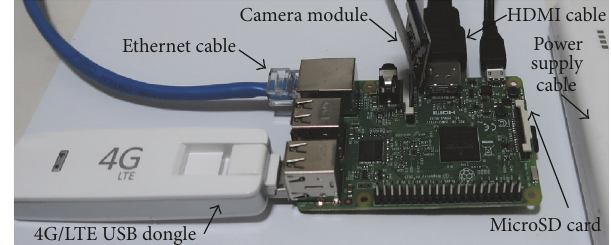
Figure 5: Microcontroller connection for fouling image recognition system.